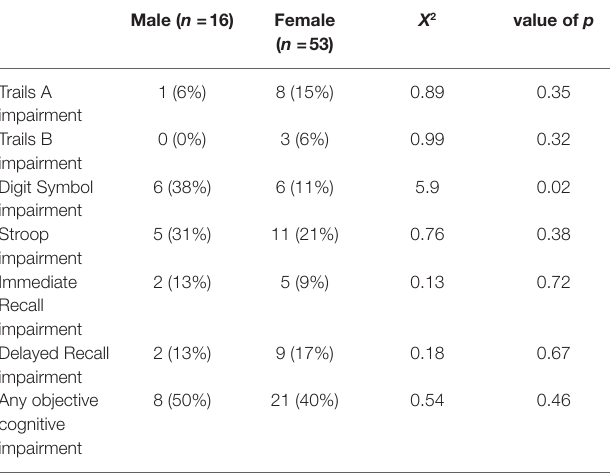
TABLE 3 | Sex and objective cognitive